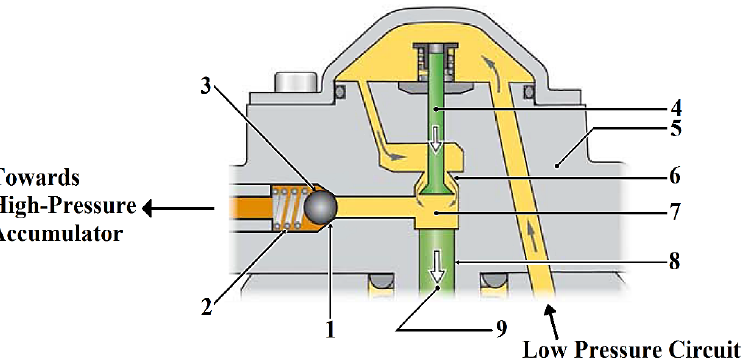
Figure 1. Hydraulic head assembly with valves and plunger [22]. 1—Outlet valve seat; 2—Outlet valve spring; 3—Outlet valve ball; 4—Inlet valve stem; 5—Hydraulic head body; 6—Inlet valve seat; 7—Compression chamber; 8—Plunger bore; 9—Plunger.